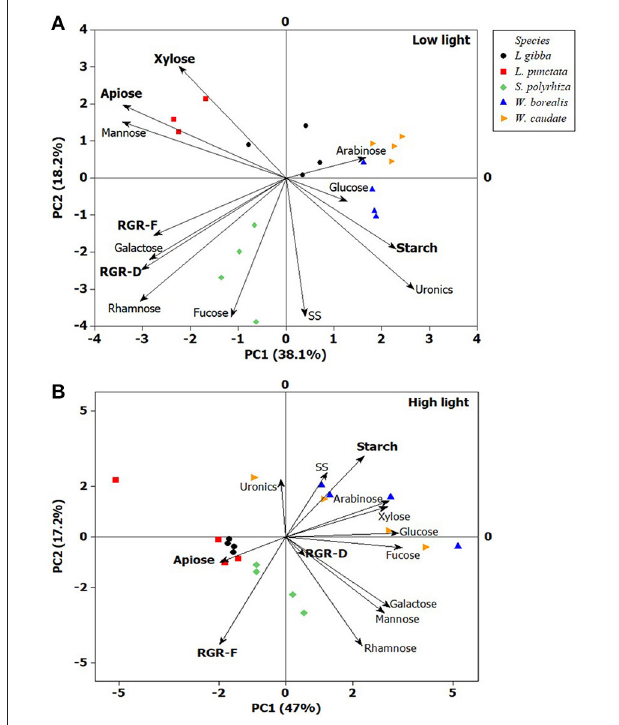
FIGURE 5 | Principal Component Analysis (PC1 and PC2) of duckweeds ( S. polyrhiza, L. punctata, L. gibba, W. caudata , and W. borealis ) grown under two light intensities. (A) low light (20 µ mol photons m − 2 s − 1 ) and (B) high light (500 µ mol photons m − 2 s − 1 ). Xylose, apiose, mannose, arabinose, glucose, galactose, and rhamnose are cell wall-related monosaccharides, uronic acids (uronics) is a component of pectin and some hemicelluloses, starch and SS (Soluble Sugars) represent non-structural carbohydrates, and RGR (Relative Growth Rate) based on number of fronds (RGR-F) and dry mass (RGR-D). The vector values and statistical analyses are in the Supplementary Table 2. ( n =